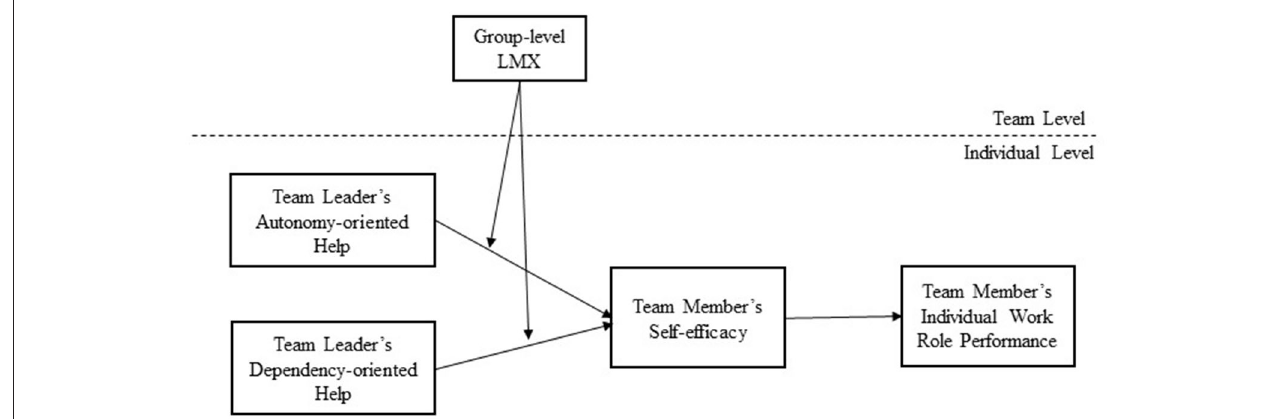
FIGURE 1 | Hypothesized